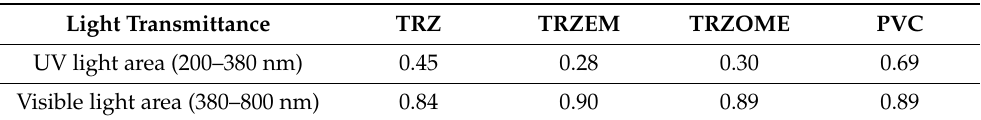
Figure 1. Synthesis route of S-triazine compounds. Table 1. The fluorescence quantum efficiency at solid state and light transmittance in films of TRZ, TRZME, and TRZOME.